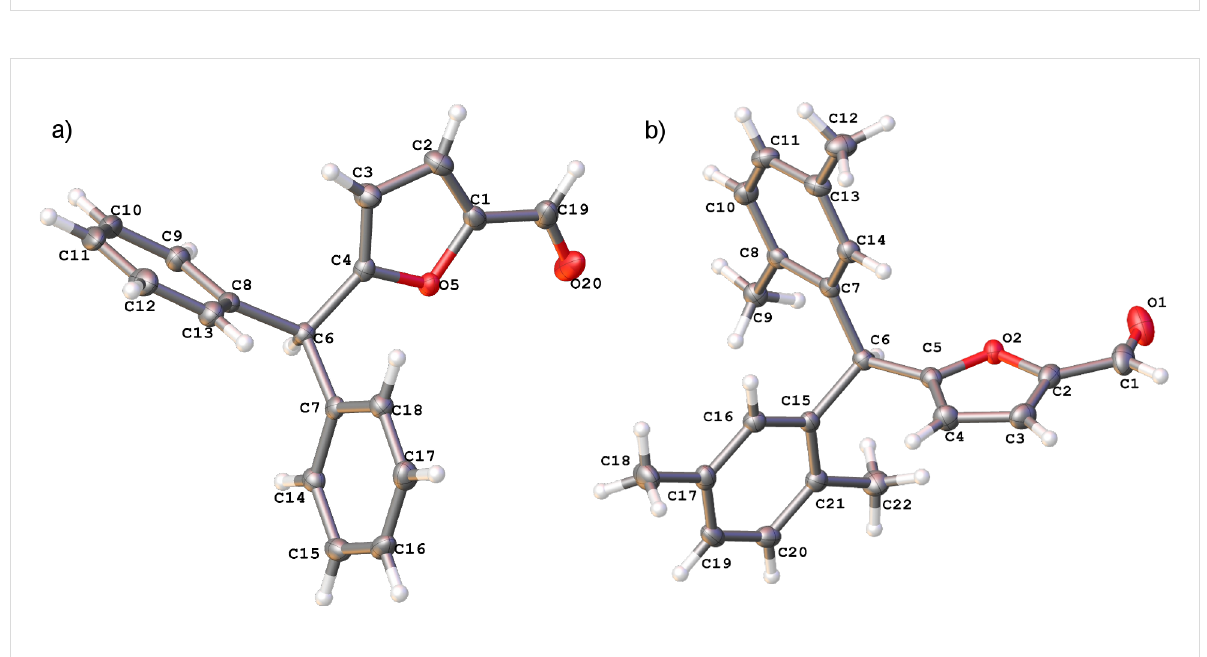
Figure 2: X-ray crystal structure of compounds 5a (a), and 5c (b) (ORTEP diagrams, ellipsoid contour of probability levels is 50%, CCDC reference numbers 5a : 1483523, 5c :